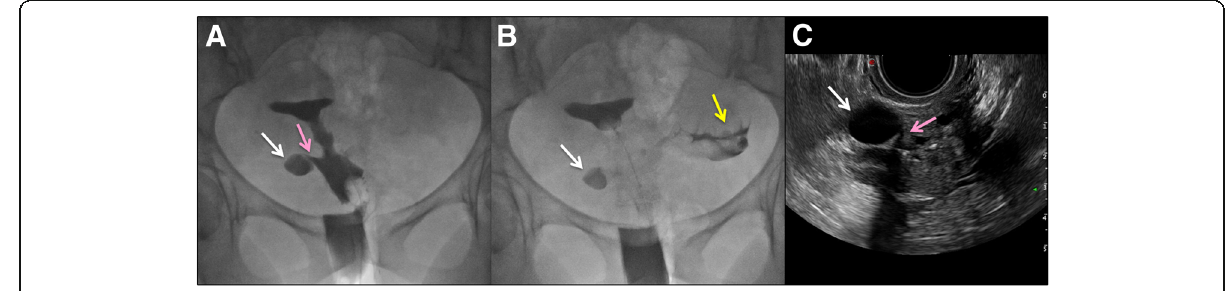
Fig. 8 A hysterosalpingography ( a , b ) was performed for infertility after a previous cesarean delivery and right tubectomy due to a previous ectopic tubal pregnancy. a , b showed right antero-lateral istmocele (white arrow) in continuity with endometrial cavity (pink arrow), b demonstrated left normal intraperitoneal spill of contrast (yellow arrow). c Transvaginal US confirmed all findings and well demonstrated the continuity between the istmocele (white arrow) and the endometrial cavity (pink